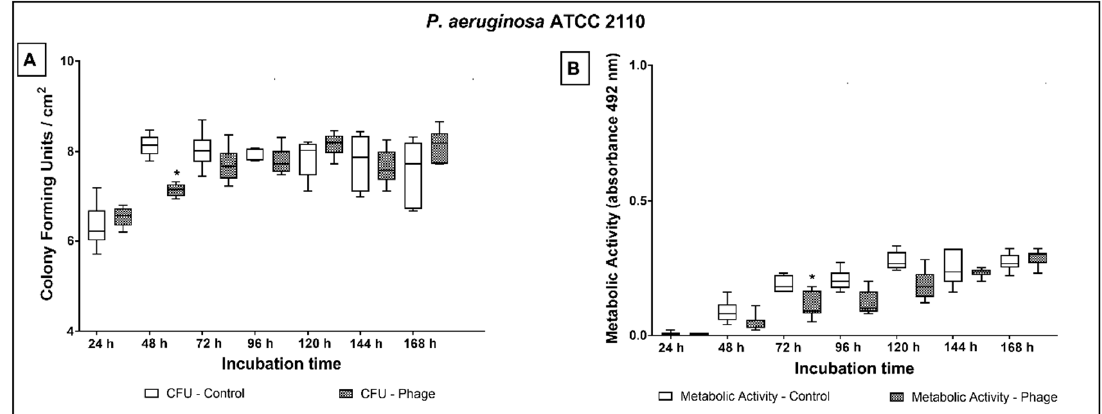
Figure 4. Biofilm growth ( A ) and metabolic activity ( B ) of P. aeruginosa ATCC 2110 over 24 to 168 h of dynamic biofilm growth on non-coated and phage cocktail-coated tubes. Comparisons were conducted among groups, at each time point, by means of multiple comparisons considering strains and phage cocktail treatment in a generalized linear model with Bonferroni correction. * indicates statistically significant difference at each time point ( p < 0.05).